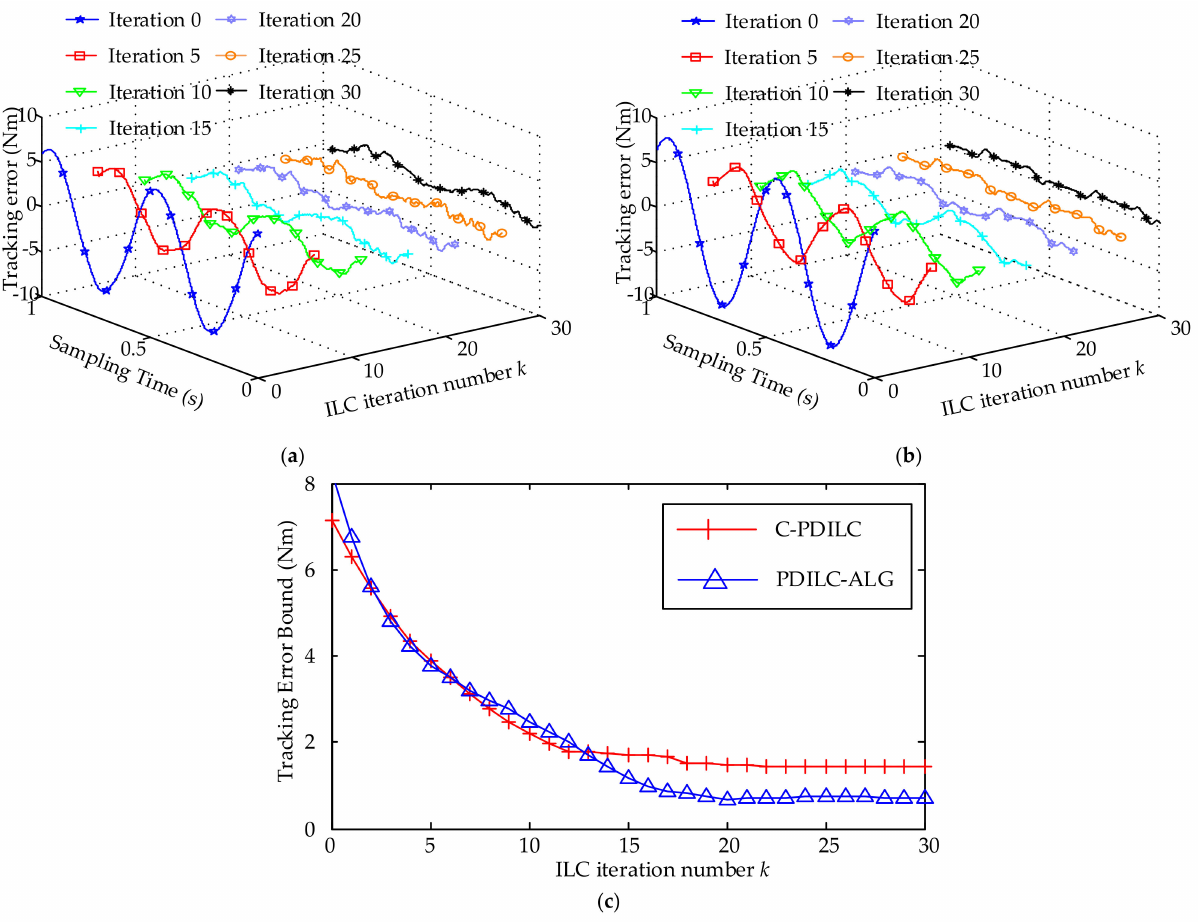
Figure 7. Case 2 experimental results ( θ ∗ a ( t ) = 4 ◦ sin ( 4 π ih ) , y d ( t ) = 30sin ( 4 π ih ) ): ( a ) Loading torque tracking errors at different iterations of the conventional PD-type iterative learning control. ( b ) Loading torque tracking errors at different iterations of the proposed PD-type iterative learning control with adaptive learning gains. ( c ) The error bound comparisons of loading torque tracking for 30 iterations.